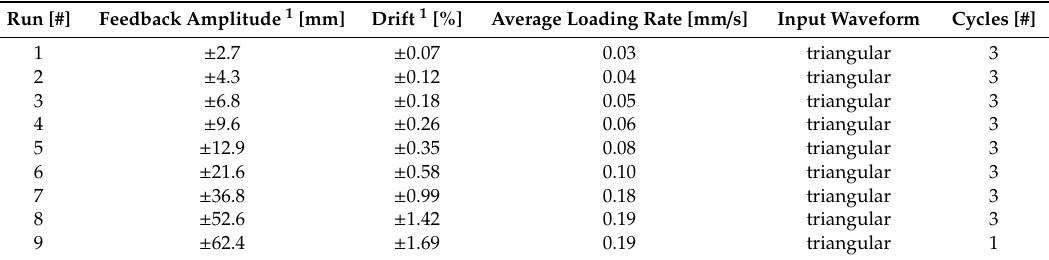
Table 3. Testing protocol.